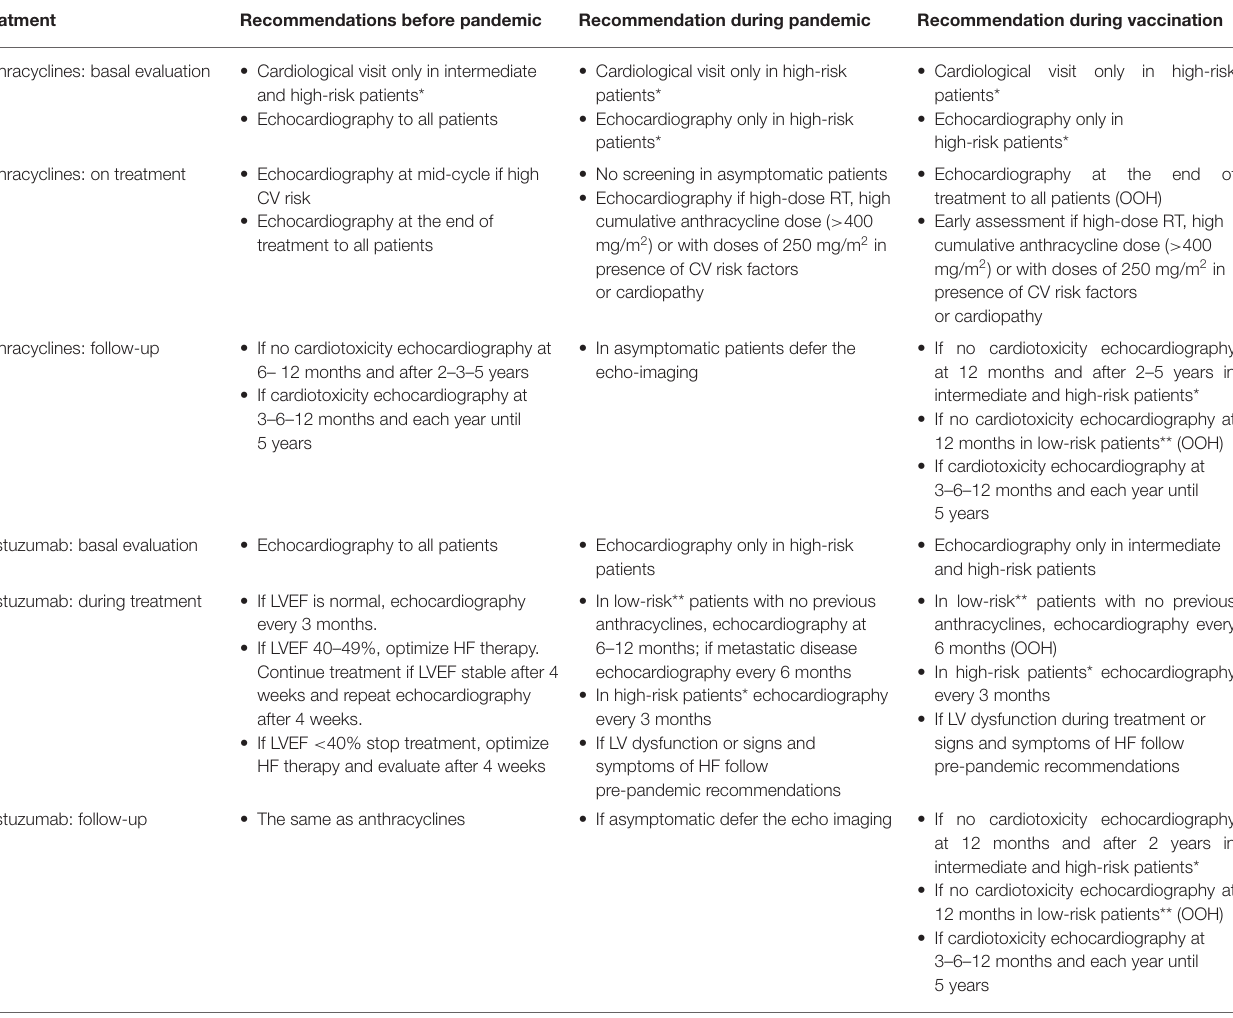
TABLE 3 | Proposal for a risk-based approach to planned cardiac monitoring during anthracycline and trastuzumab treatment in the vaccination era.